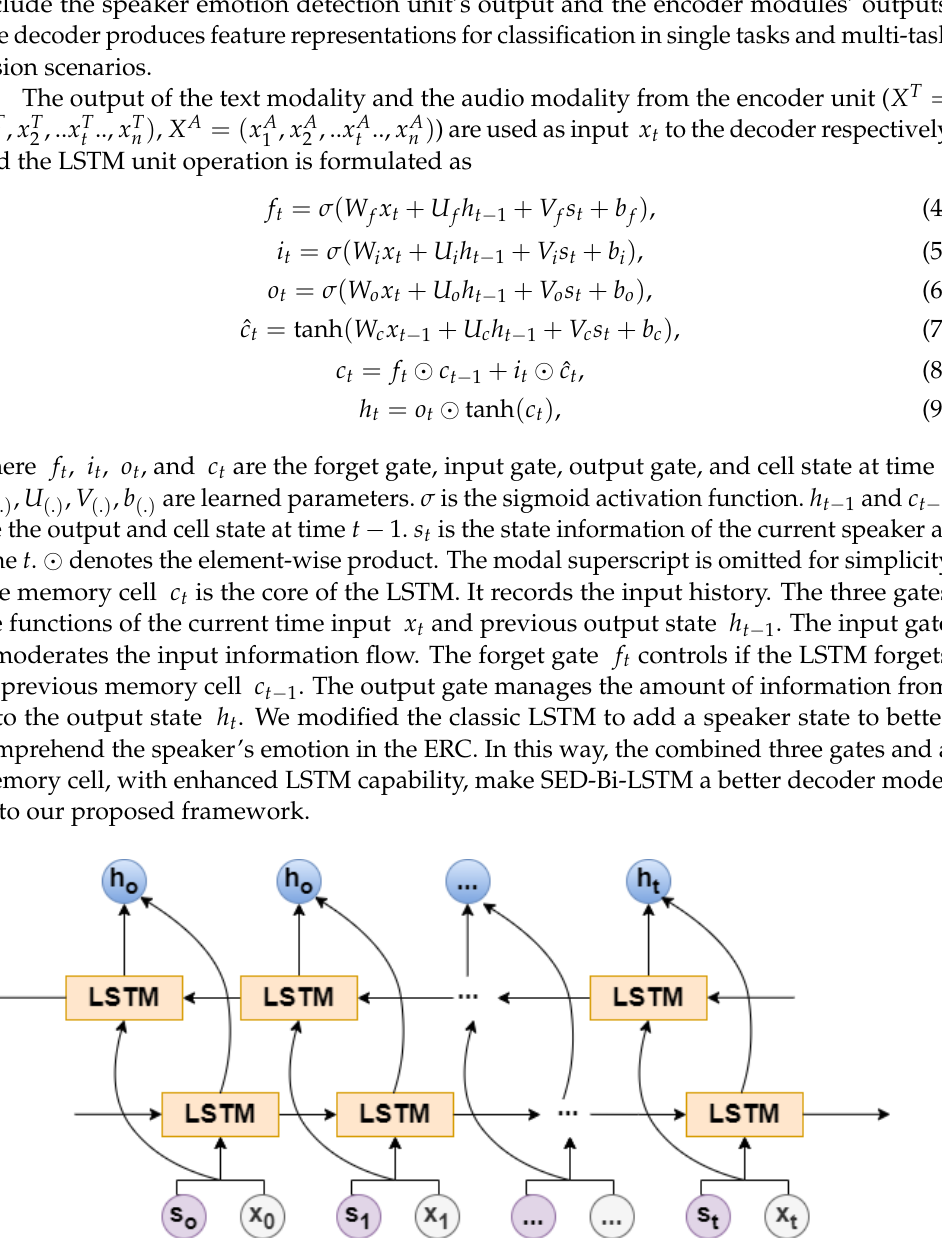
Figure 2. Network architecture of the speaker emotion detection Bi-LSTM (SED-Bi-LSTM), S t and X t are speaker state and encoded audio or text